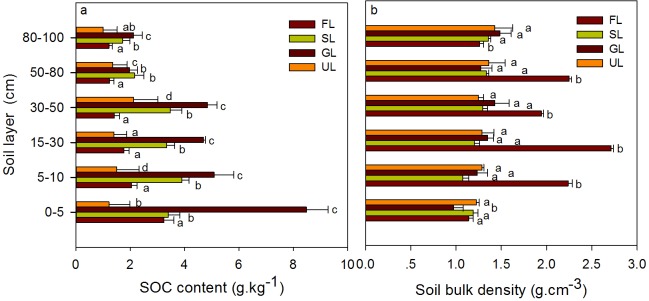
SOC content and soil bulk density in the four land use/cover types in 2010.Bars and error bars represent mean and standard errors, respectively. Different letters above the bars show significant differences (P<0.05) among four land use/cover types.